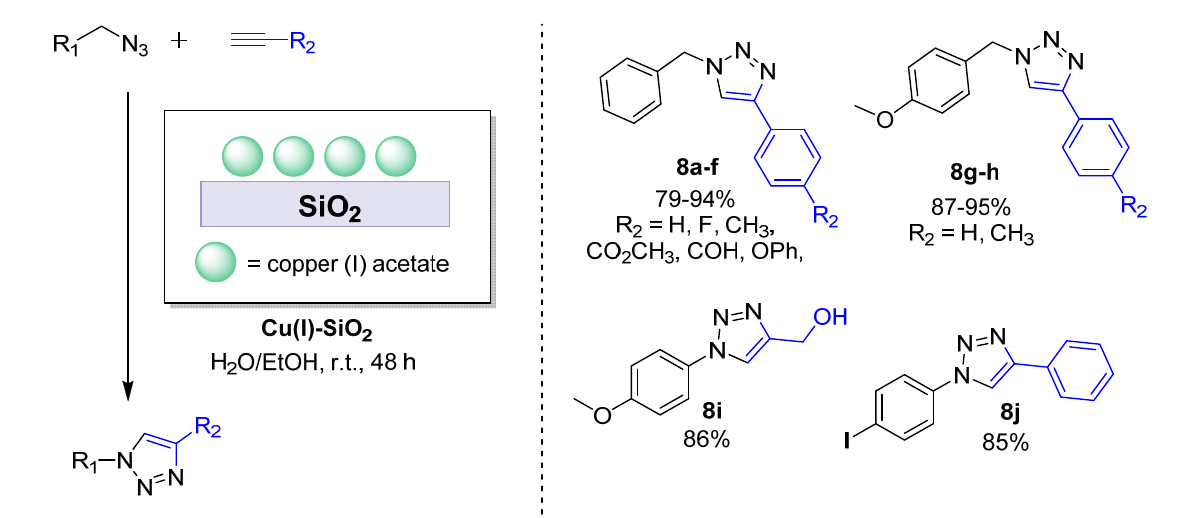
Scheme 8. Synthesis of 1,4-disubstituted-1,2,3-triazoles via copper (I) acetate-anchored silica-catalyzed azide-alkyne cycloaddition reactions (derived from [11]).